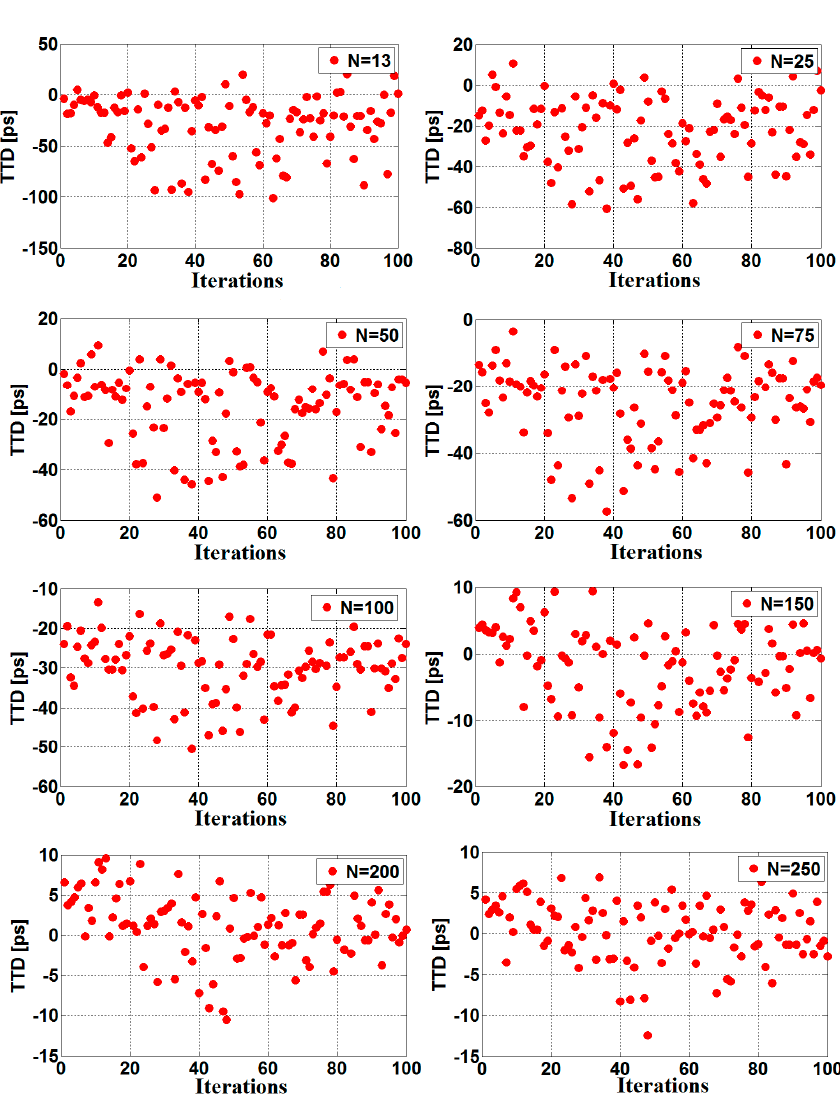
Figure 8. TTD results measured for different number of fitted samples (N).